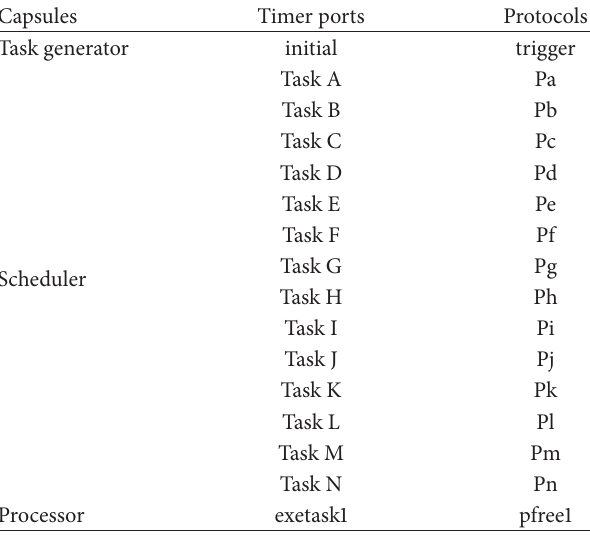
Figure 2: Problem area 𝜑 𝑘 , for the task 𝜏 𝑘 . Table 2: Capsules and associated ports.